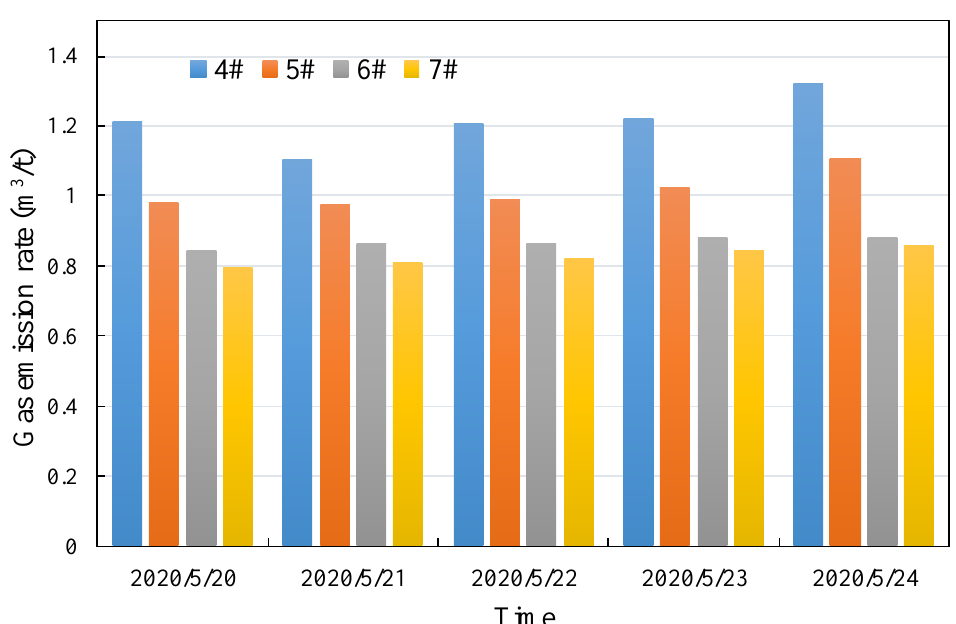
Figure 2. Analysis of measured value of gas emission in working face.